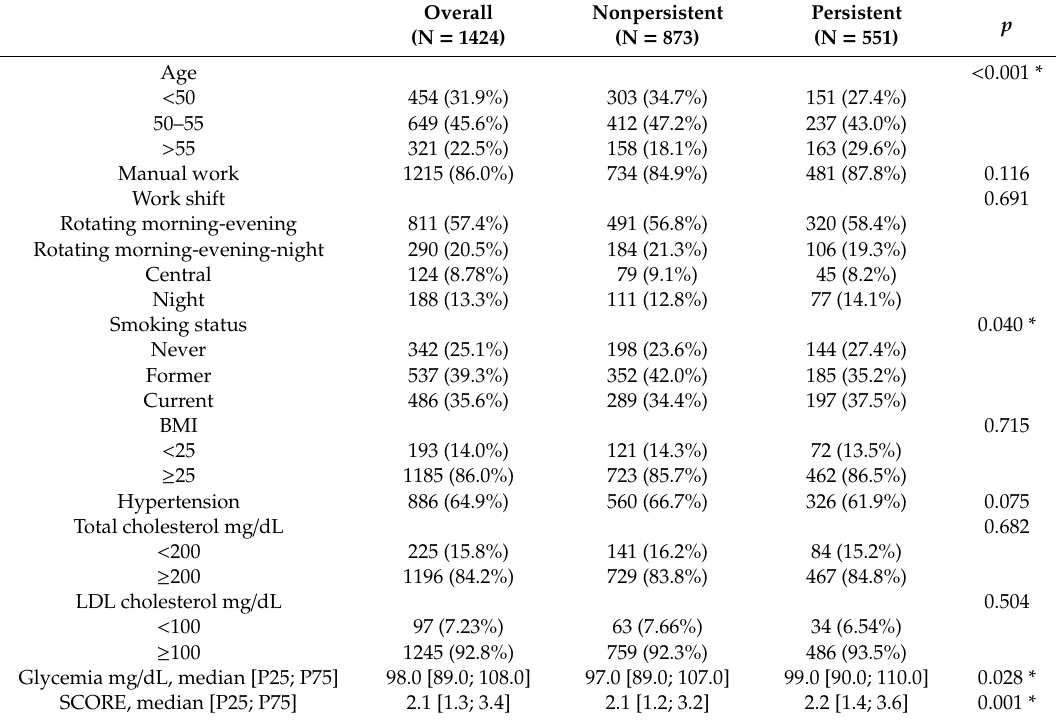
Table 1. Descriptive statistics for new male users of lipid-lowering drugs for primary cardiovascular disease prevention: overall and stratified by